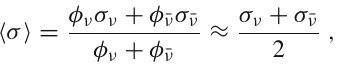
correspond to statistical uncertainties, the shaded regions show uncer- taintiesfromneutrinoproductionratecorrespondingtotherangeofpre- dictions obtained from different MC generators, and the dashed error bars show their combination. Here we include the geometrical accep- tance, vertex detection efficiency and lepton identification efficiency as discussed in the